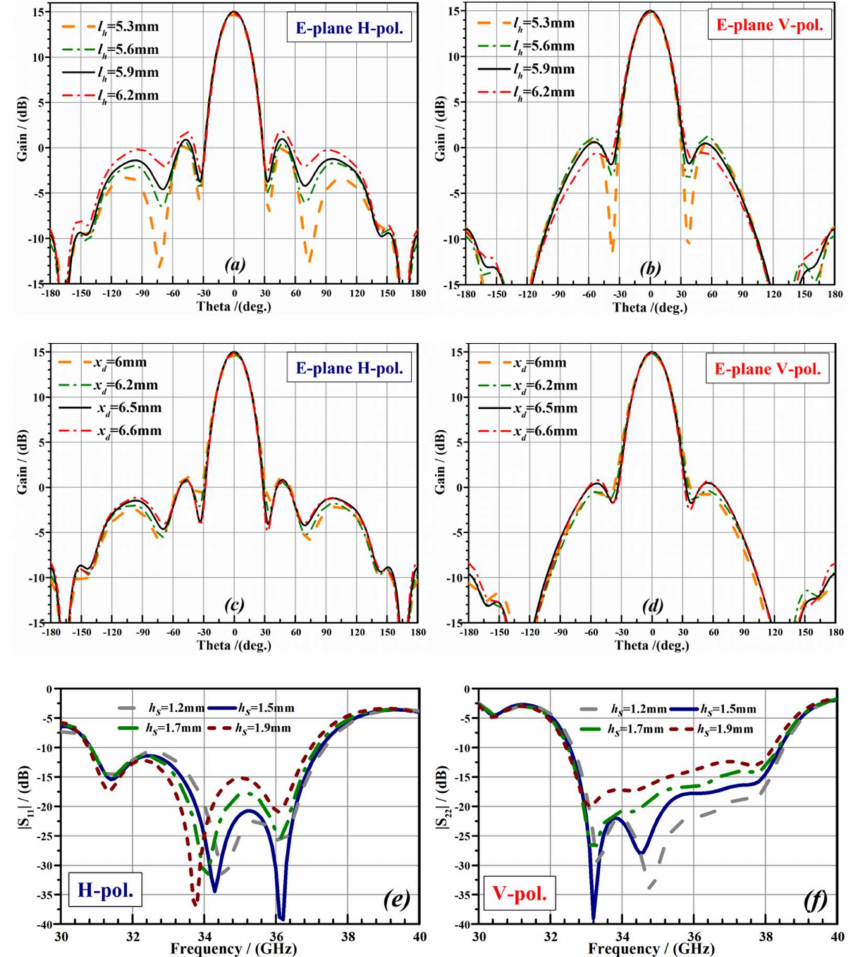
Figure 5. Parameter analysis of the subarray: ( a , b ) length of cross-slots; ( c , d ) distance between the ME-dipole units; ( e , f ) heights of the square WG to cross-slots transition